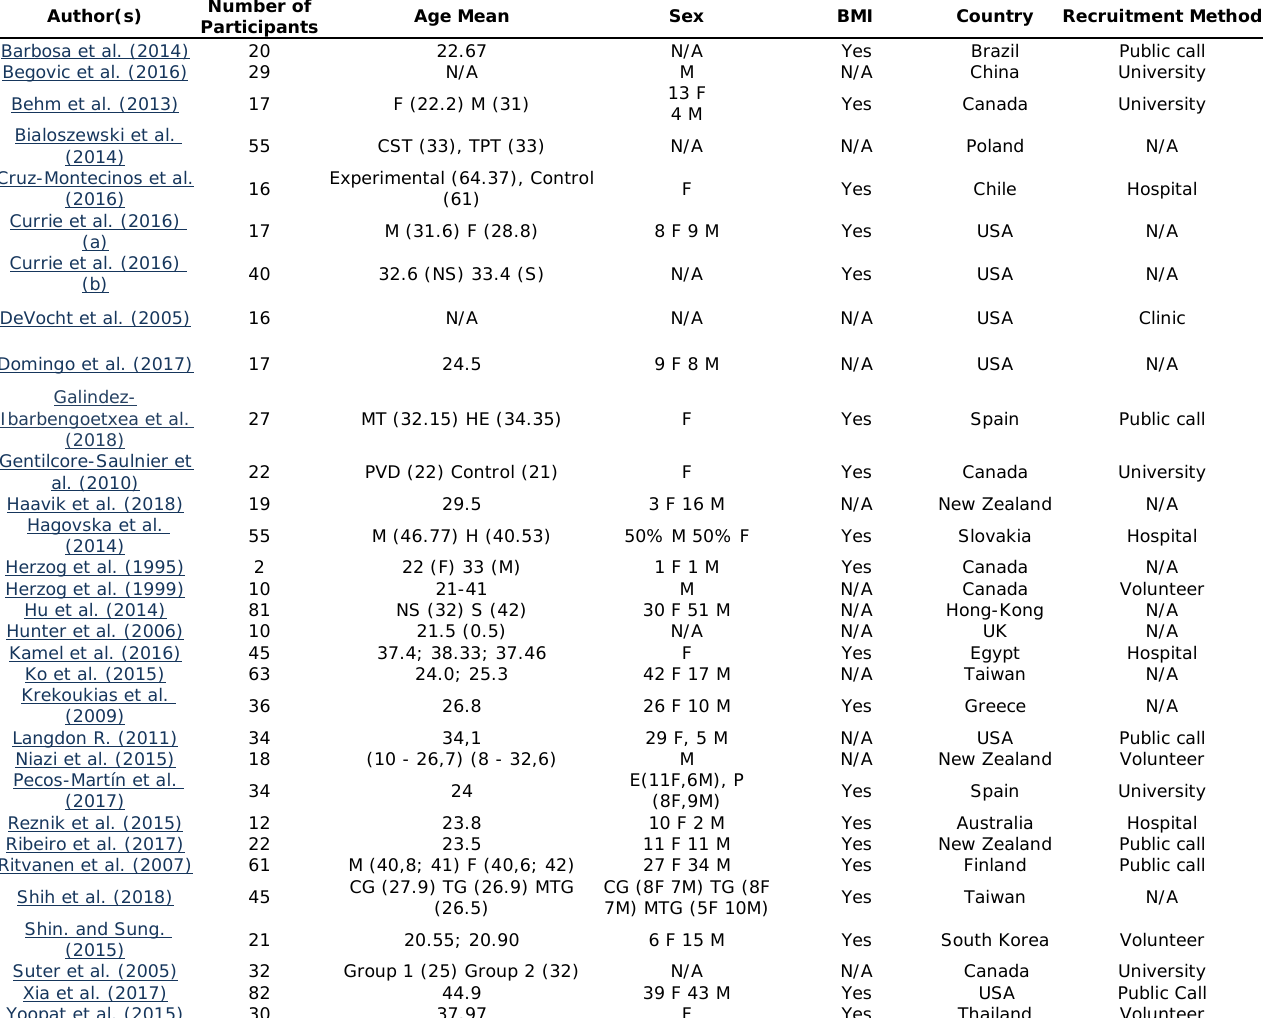
Table 1. Use of sEMG in Manual Therapy: